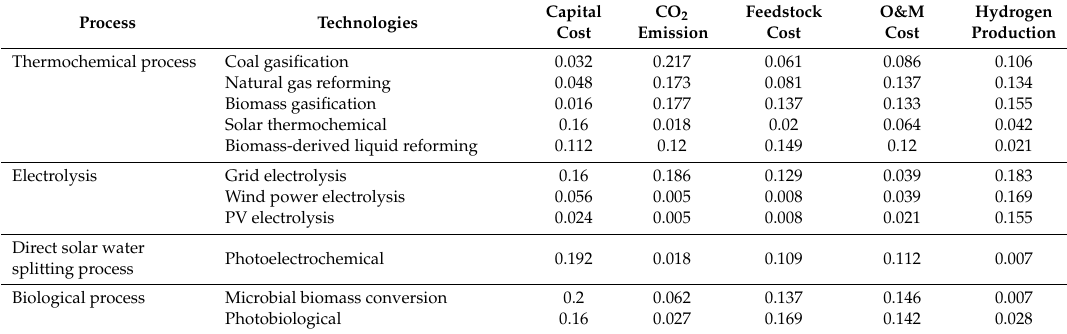
Table 9. Normalized ultimate weights.